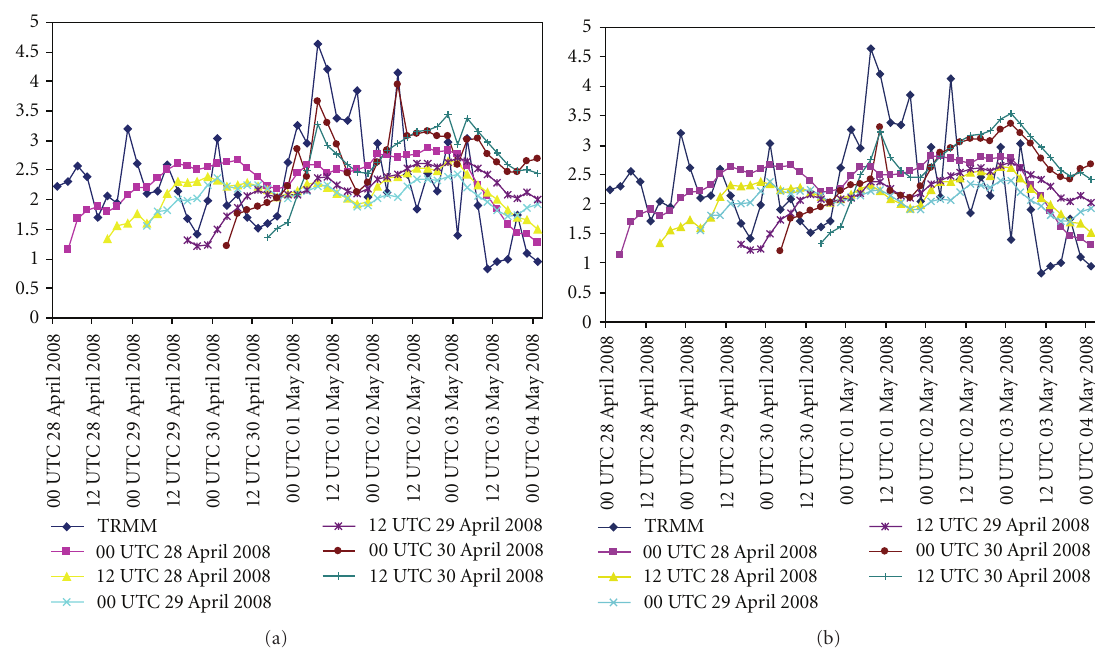
Figure 8: Time-series of area-averaged rainfall (cm hr − 1 ) from TRMM and model simulation at di ff erent initial conditions. (a) Comparison among TRMM and model simulation with NMM land surface scheme and (b) same as (a) but with NOAH land surface scheme. Table 2: Mean absolute track errors (km) with two optimum physics combinations with di ff erent initial conditions. Initial